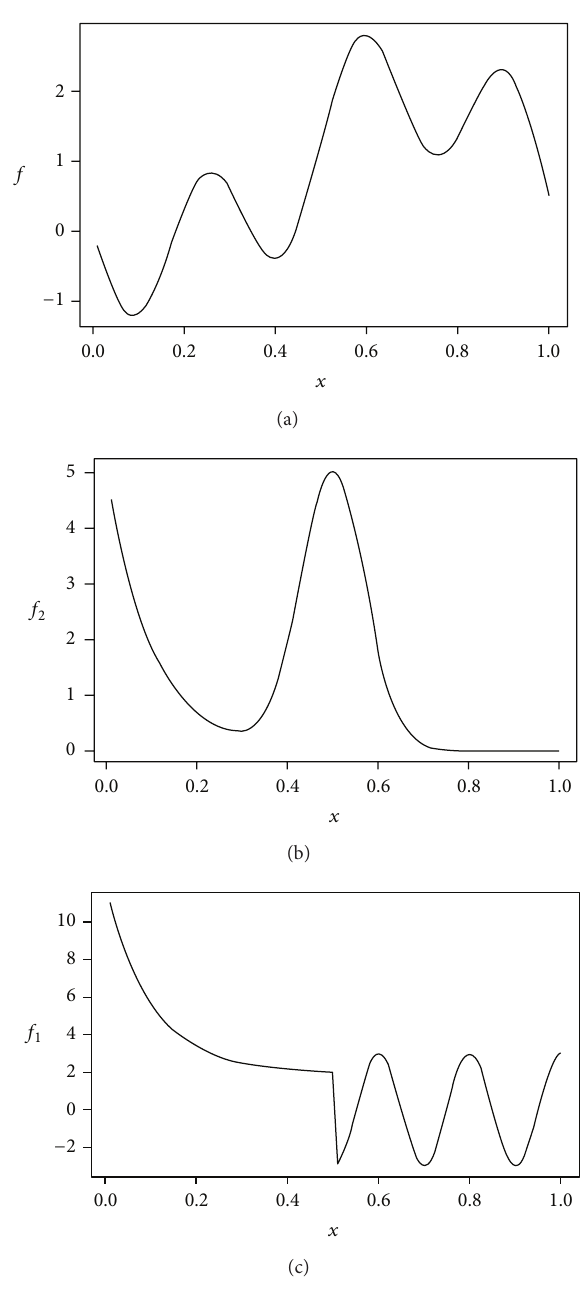
Figure 1: Three test functions used in the